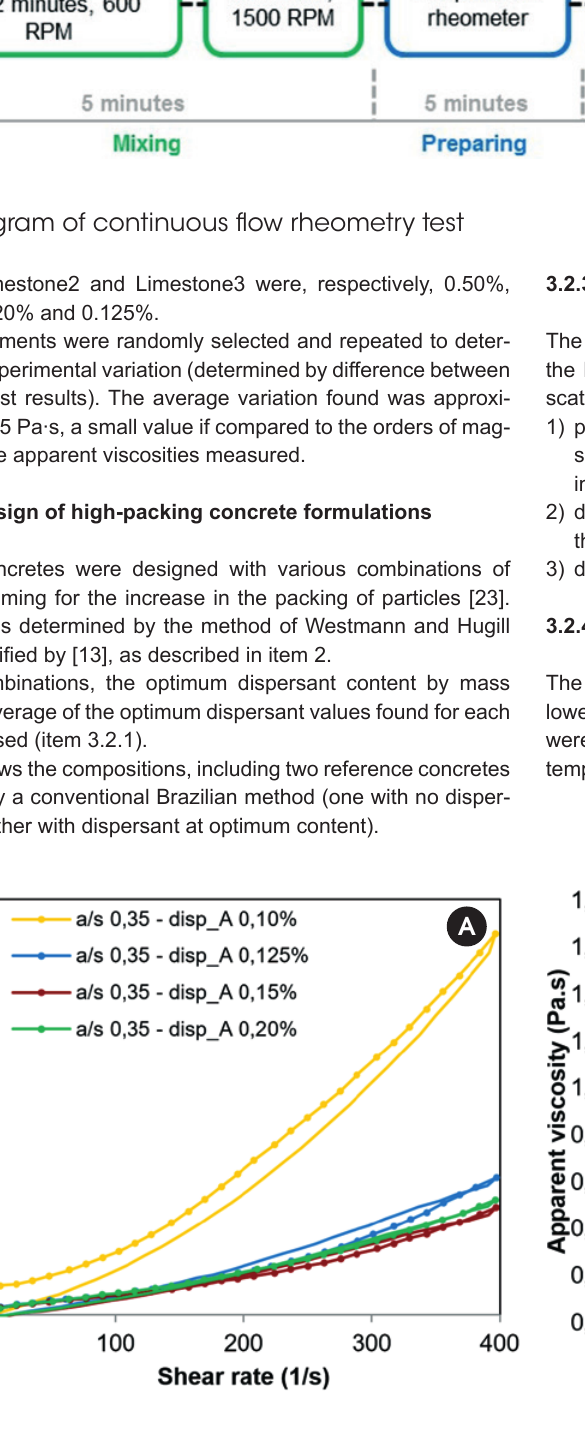
Determination of the optimal dispersant content of the Limestone3: a) shear rate curves x shear stress curves for 4 dispersant contents (4 different flow rheometry tests); b) "dispersant content x apparent viscosity" of the same tests. The rheological curve for the dispersant content = 0 was not shown since viscosity achieved was very